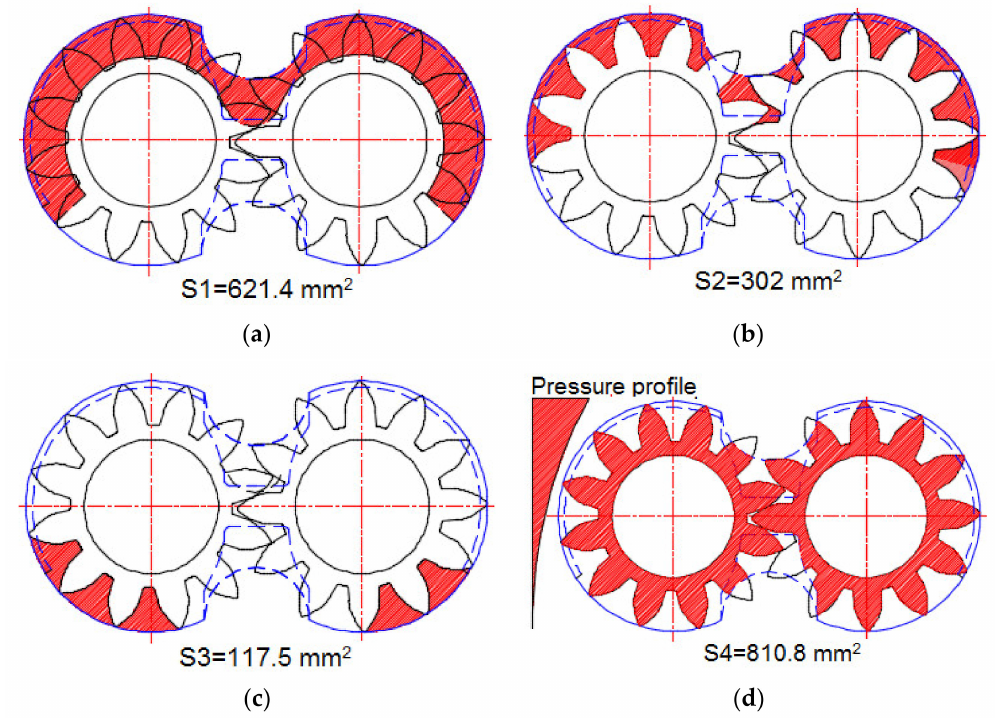
Figure 3. Areas subject to pressure in the floating bushing: ( a ) S1, the back side area; ( b ) S2, the between-teeth area; ( c ) S3, the pressure gradient area between the teeth; and ( d ) S4, the lateral area between the gear and